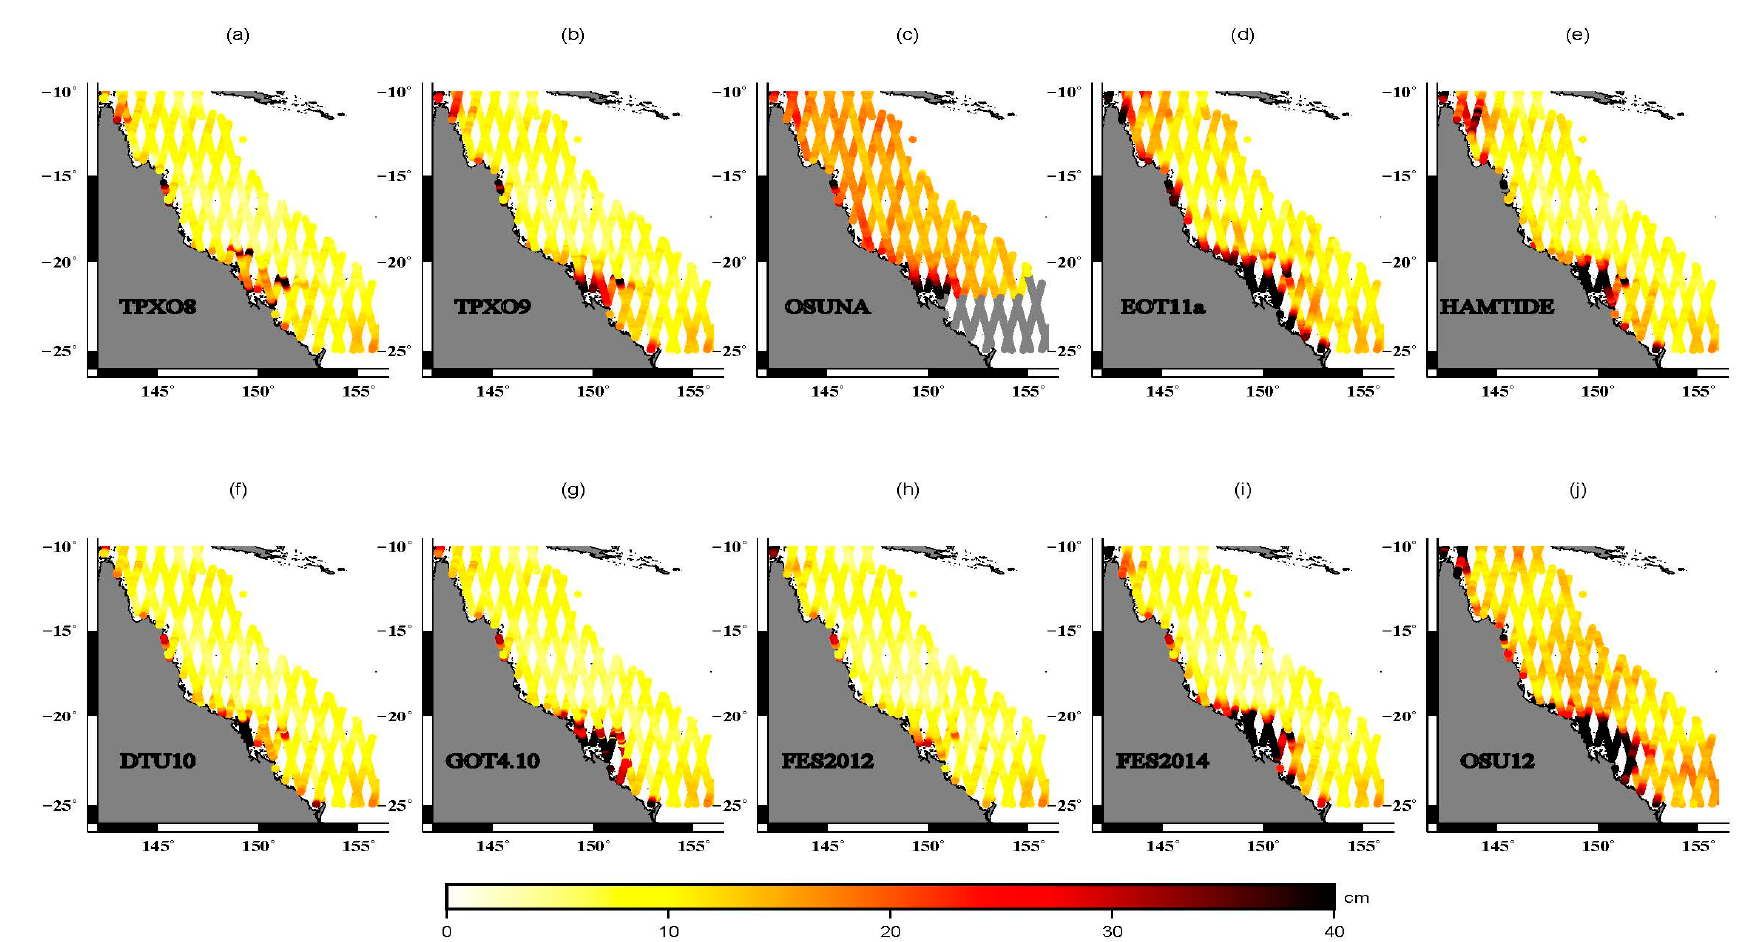
Figure 5. The distributions of the RMS values of the SLA of Sentinel-3A along-track locations, detided by tidal models. Gray values in ( c ) are for locations beyond the geographic coverage of OSUNA. The black color stands for values above 40 cm of RMS.